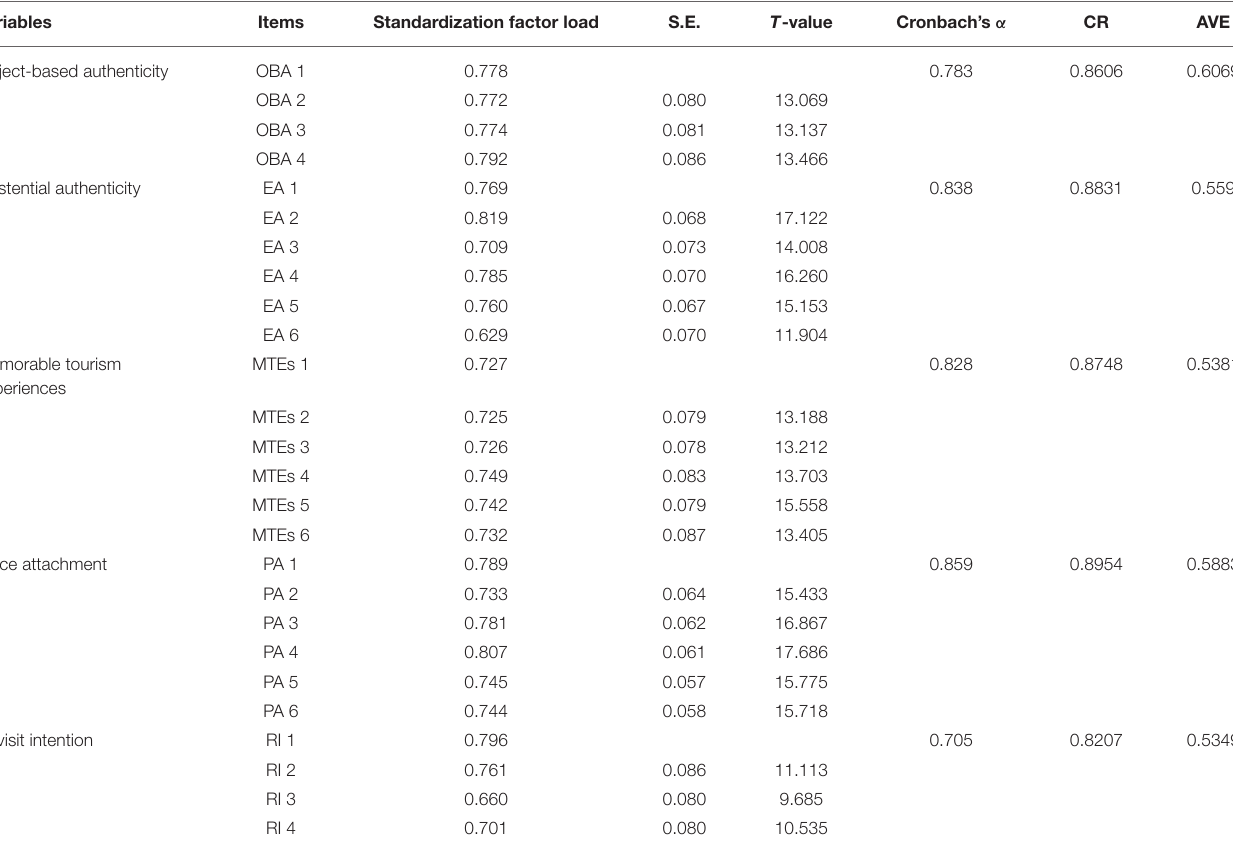
TABLE 1 | Reliability coefficients and the average variance extractions (AVEs) of the